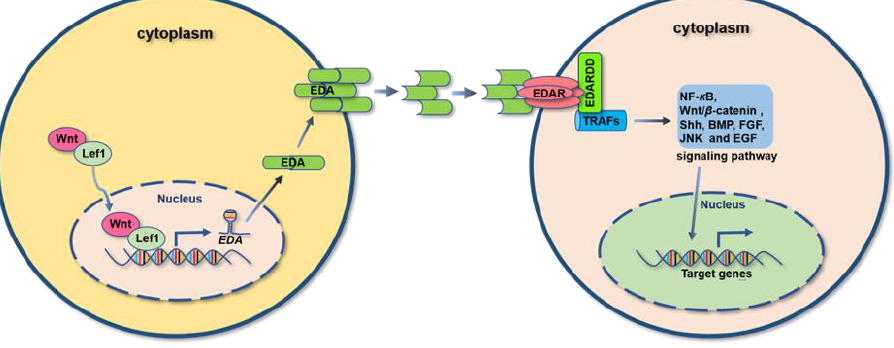
Figure 1. Schematic representation of EDA